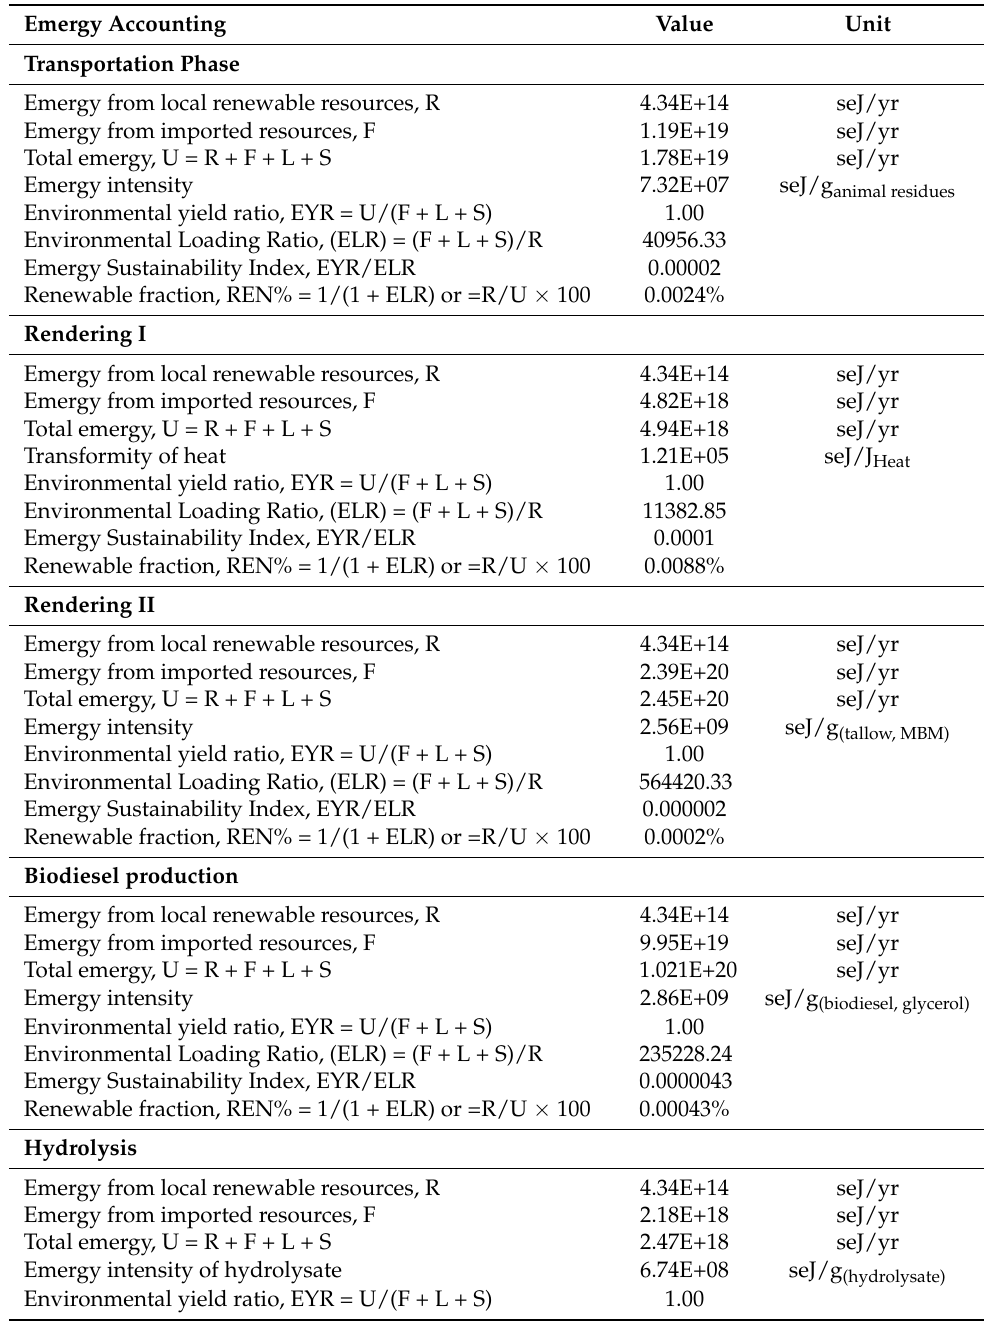
Table A1. Emergy-based indicators calculated for the biobased PHA production using facility area as the system